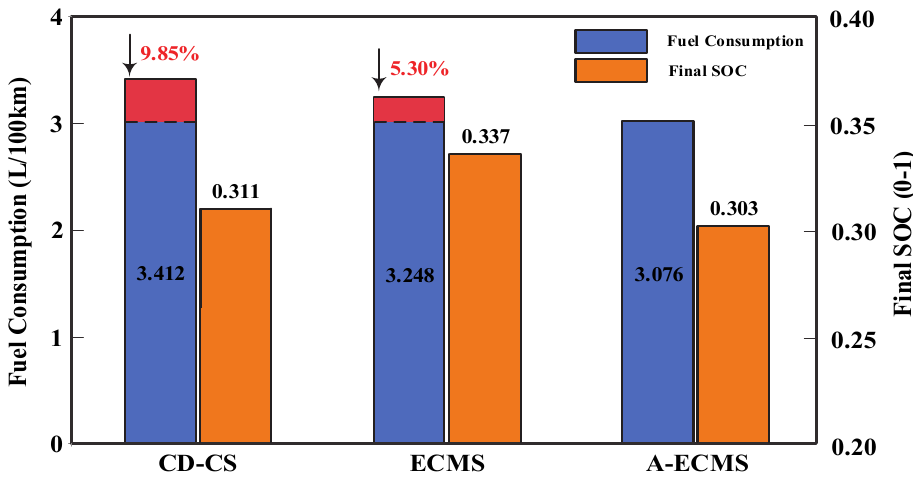
Figure 18. SOC decline trajectories under different strategies.